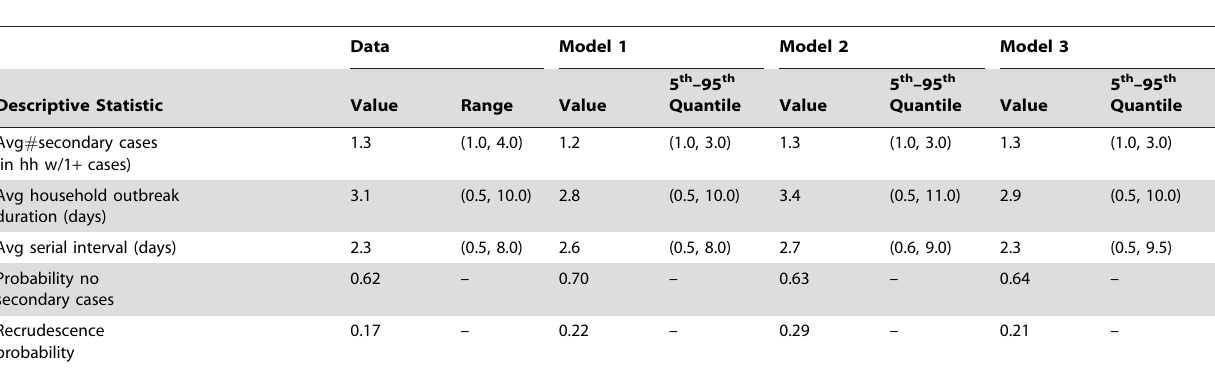
Table 3. Descriptive characteristics of household outbreak data compared to 10ˆ4 simulations from fitted Models